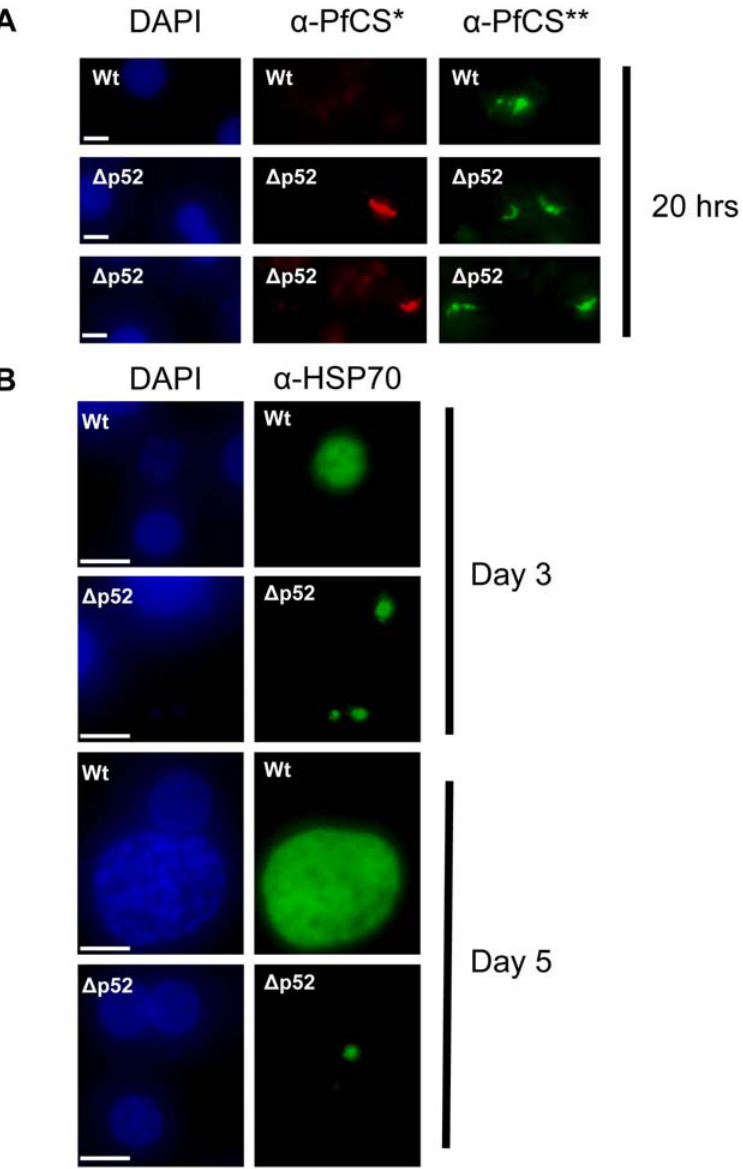
Figure 4. Development of wild-type and D p52 parasites in primary human hepatocytes. (A) Parasites at 20 hours. Extracellular parasites are visualised by staining with anti-PfCSP antibodies (secondary conjugated with ALEXA594, i.e. red fluorescence) before permeablisation ( a -PfCS*) and all parasites are visualised by staining with anti-PfCSP antibodies (secondary conjugated with ALEXA488 i.e. green fluorescence) after permeablisation ( a -PfCS**). The nuclei of the host cells are stained with DAPI (blue). (B) Parasites at day 3 or day 5. Nuclei of both the host cell and the merozoites inside the developing schizont are visible by DAPI staining (blue). Parasites are identified by anti-HSP70 staining ( a -HSP70; secondary antibody conjugated with ALEXA488; green). Parasite lacking P52 expression fail to develop into schizonts and the only visible forms of the parasite are small ‘rounded’, possibly degenerate and/or extracelluar, forms. Scale bars in the DAPI panels represent a size of 10 m M.